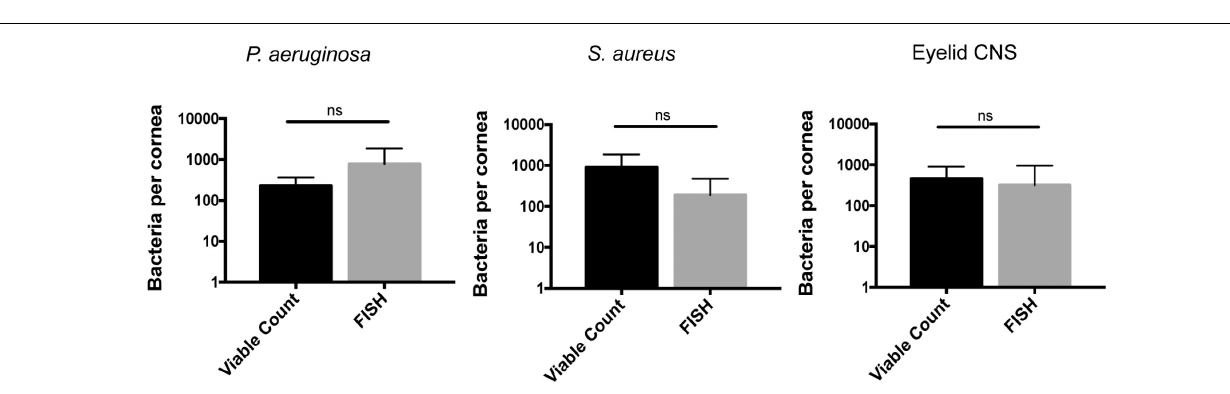
FIGURE 6 | Cornea-associated bacteria remain culturable. Number of bacteria detected per cornea using viable counts compared to FISH labeling at 24 h after uninjured mouse eyes were inoculated in vivo with ∼ 10 8 CFU of P. aeruginosa, S. aureus , or CNS. Data were expressed as the mean ± SD of bacteria identified per cornea. ns = No significant difference was found between methods used ( P > 0.05, Mann–Whitney U -test).